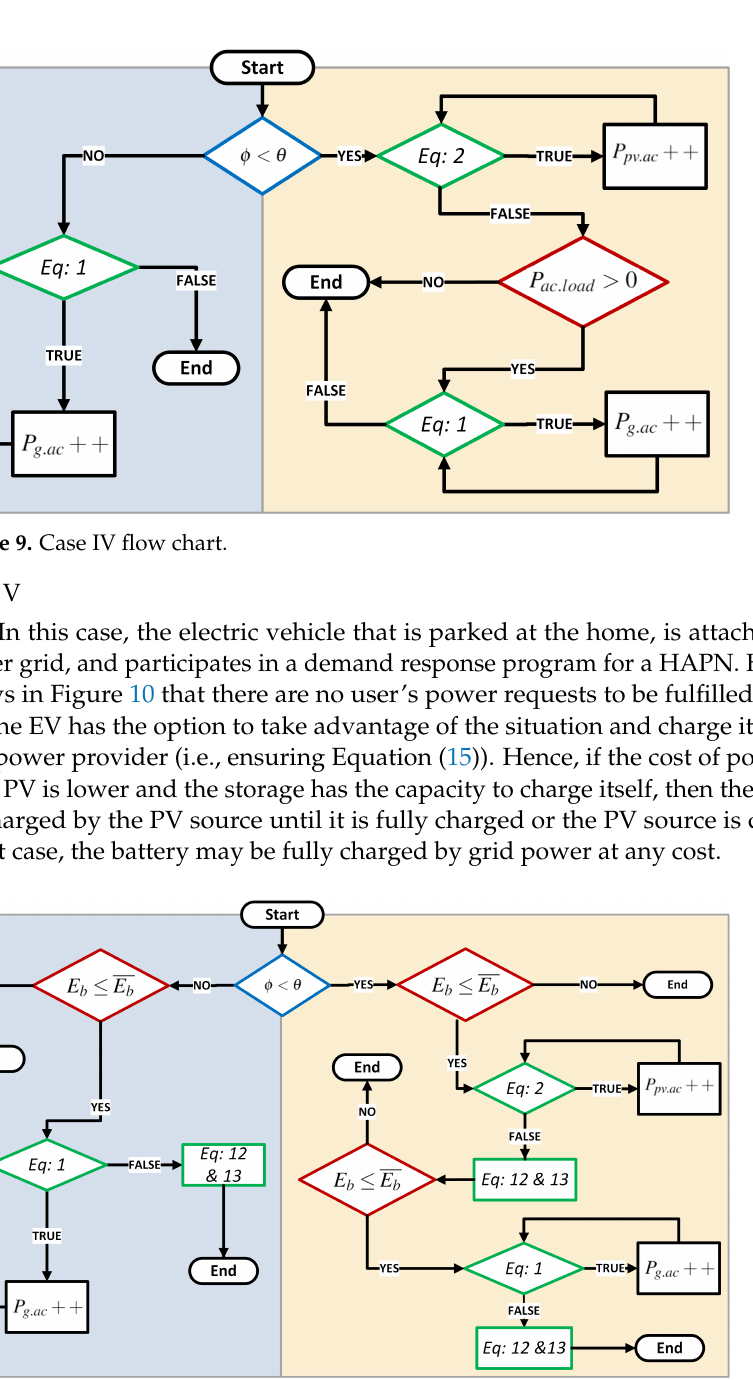
Figure 10. Case V flow chart.